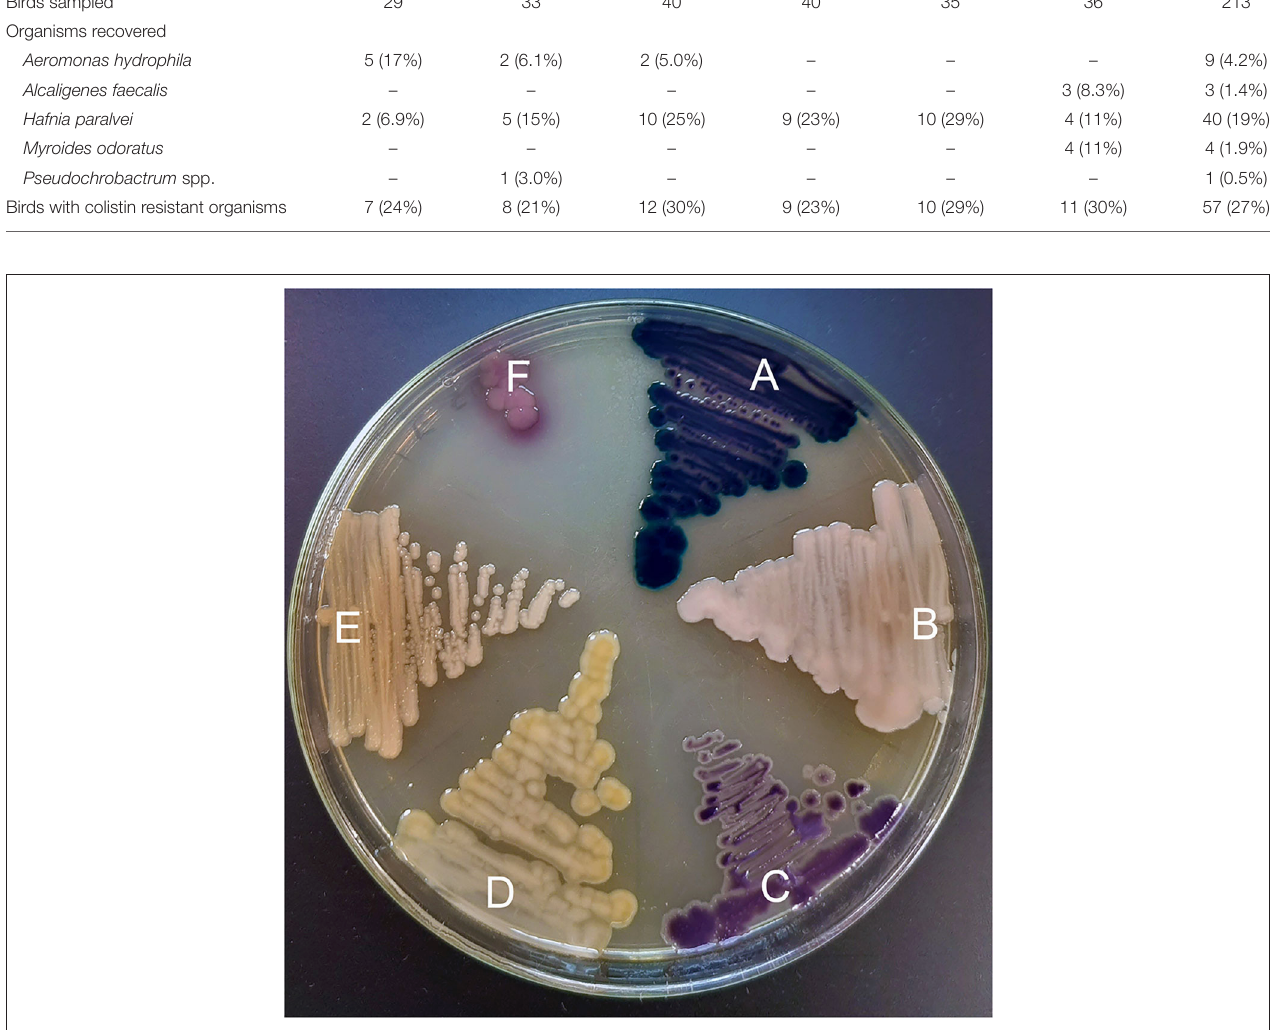
FIGURE 1 | Colistin-resistant organisms grown on CHROMagar COL- APSE agar for 48h; (A) Aeromonas hydrophila isolate C17; (B) Alcaligenes faecalis isolate F12; (C) Hafnia paralvei isolate E14; (D) Myroides odoratus isolate B27; (E) Pseudochrobactrum spp. isolate F17; (F) E. coli ATCC